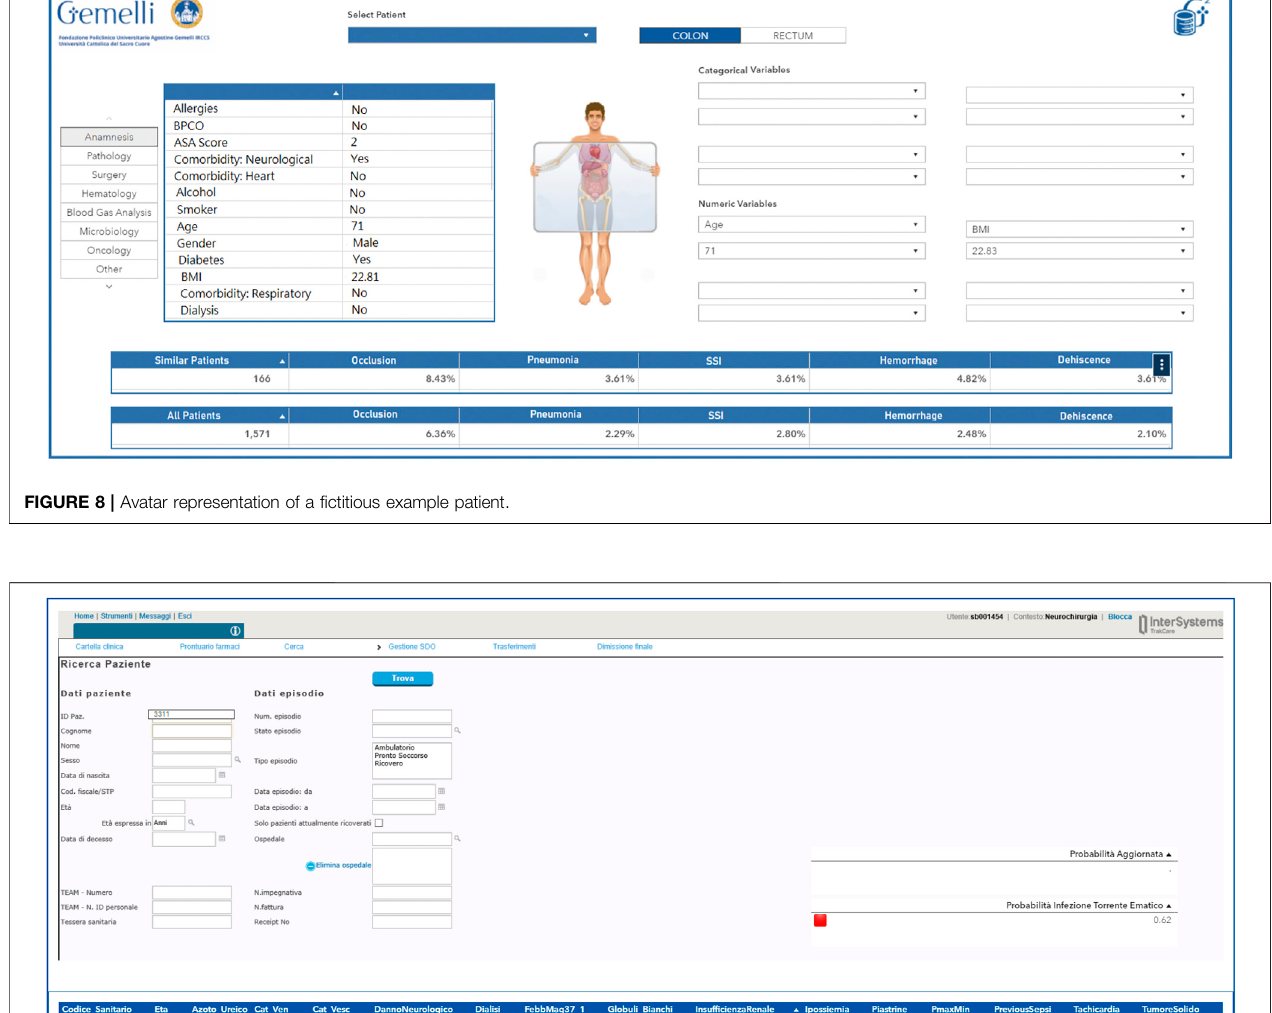
Frontiers in Computer Science |